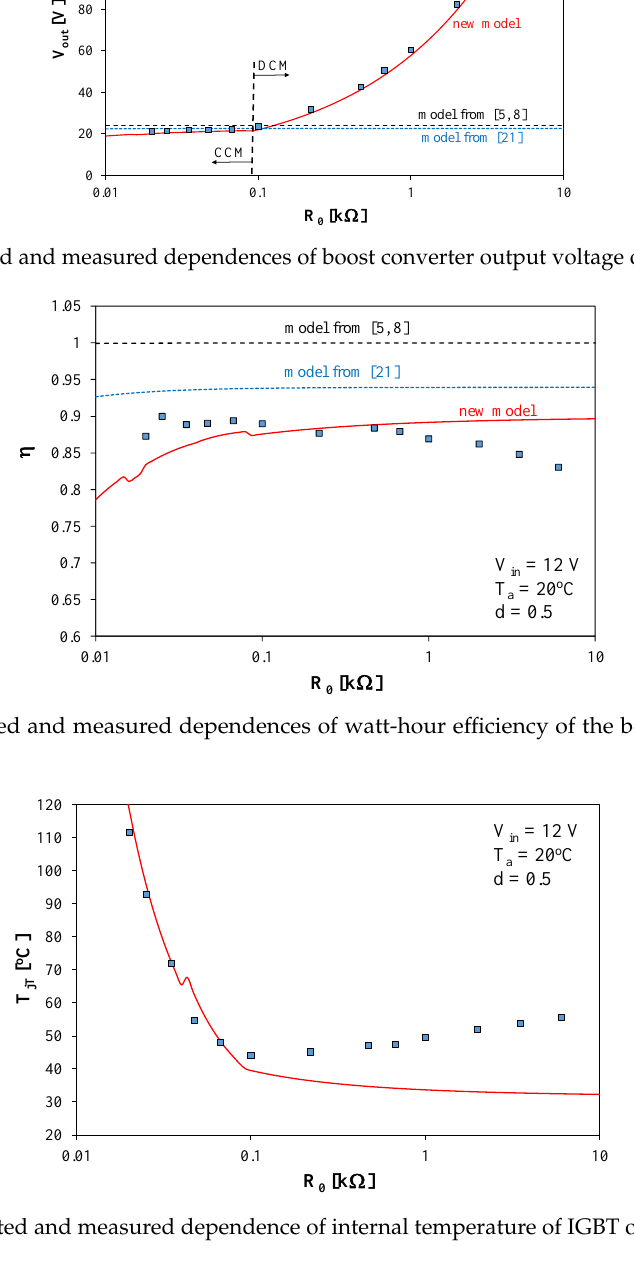
Figure 11. Computed and measured dependence of internal temperature of the diode on load resistance.